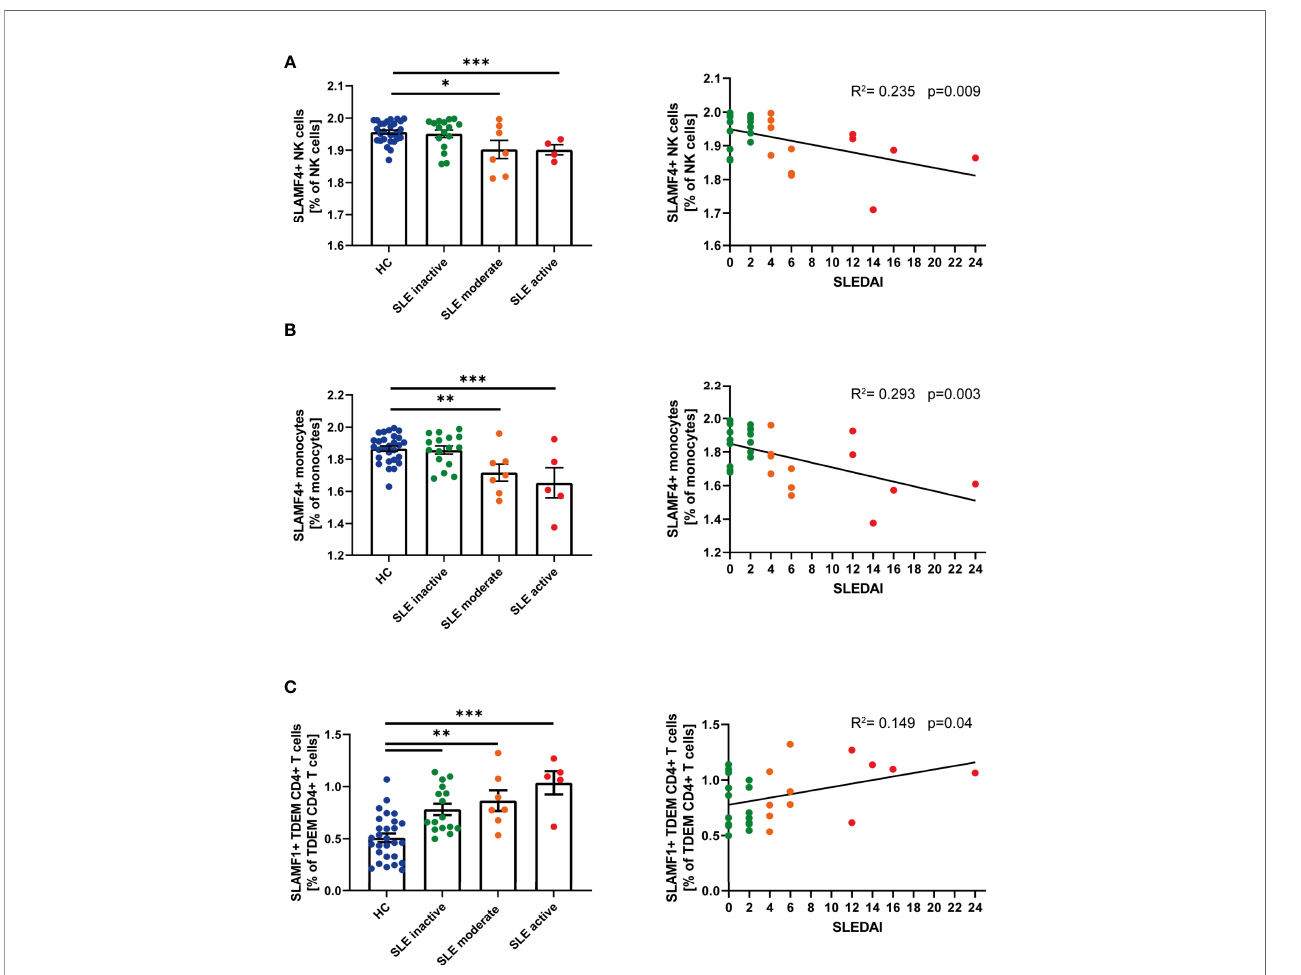
FIGURE 3 | Single SLAMF link to disease activity. (A) Frequency of SLAMF4+ natural killer (NK) cells according to disease activity categories (one way ANOVA with Tukey ’ s multiple comparison test, left) and correlation between frequency of SLAMF4+ NK cells and SLEDAI (Pearson ’ s correlation, p=0.003, right). (B) Frequency of SLAMF4+ monocytes according to disease activity categories (one way ANOVA with Tukey ’ s multiple comparison test, left) and correlation between frequency of SLAMF4+ monocytes and SLEDAI (Pearson ’ s correlation, p<0.001, right). (C) Frequency of SLAMF1+ terminally differentiated effector memory CD4+ T (TDEM) cells according to disease activity categories (one way ANOVA, left) and correlation between frequency of SLAMF1+ TDEM and SLEDAI (Pearson ’ s correlation, p=0.04, right). Data presented as log10 transformed values,*p=0.02, **p=0.002,